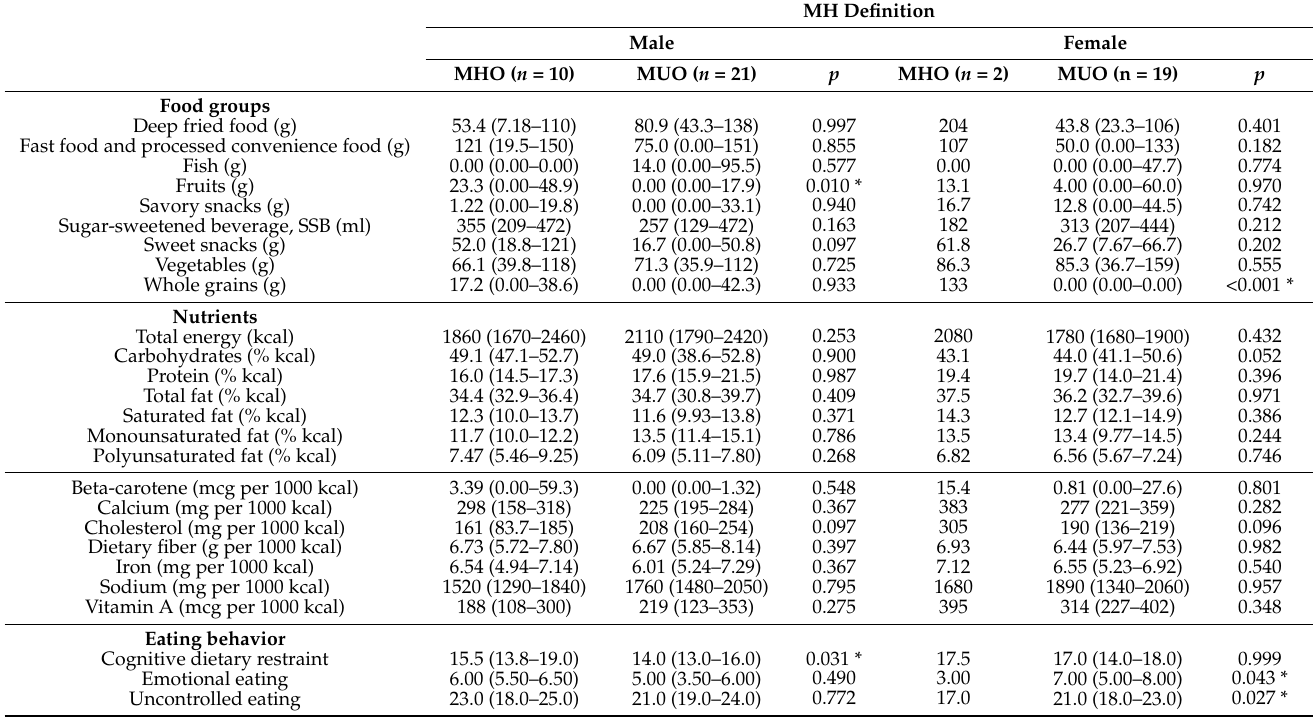
Table 3. Food groups, nutrient intakes and eating behavior between children/adolescents with MHO and children/adolescents with MUO (MH definition) stratified by